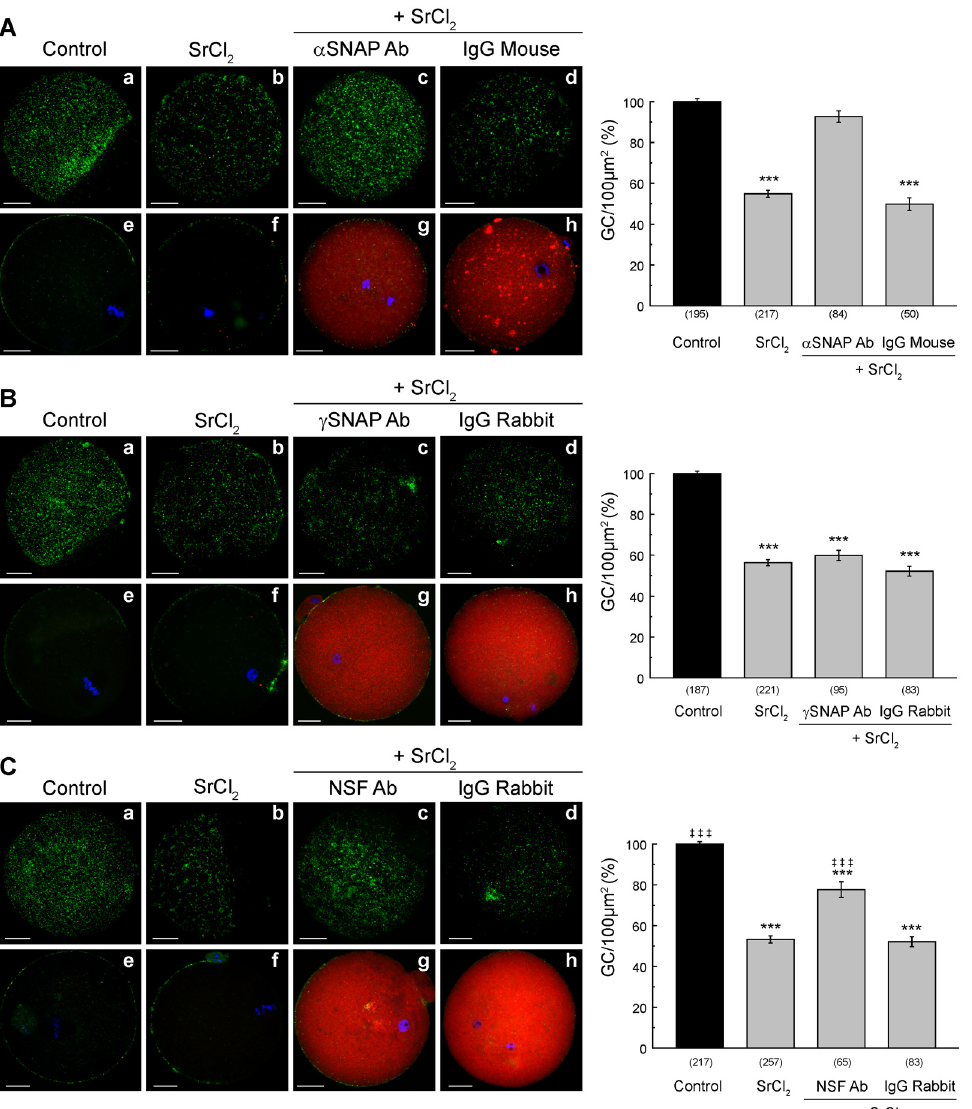
Fig 6. Effect of microinjection of α -SNAP, γ -SNAP and NSF antibodies on CGE. MII oocytes were microinjected with α -SNAP ( A ), γ -SNAP ( B ), and NSF ( C ) antibody and CGE was triggered with 30mM strontium chloride (SrCl 2 ). Mouse and rabbit IgGs were microinjected as isotype controls at the same concentrations. Left : a - d , representative images of cells stained with FITC-LCA to label CG. e - h , representative images of oocytes subjected to inmunofluorescence protocol, were primary antibody was omitted, and secondary antibodies: Cy3 donkey anti-mouse in A , and Cy3 donkey anti-rabbit in B and C , were used to confirm proper microinjection of antibody or control isotype (red). Right ,Histogram showing % CG density/100 μ m 2 relative to untreated group (Control) set as 100%. Data are shown as mean ± SEM from at least 4 independent experiments; numbers in parentheses below bars represent total number of oocytes. *** , values compared to control, p (cid:1) 0.001; ‡ ‡ ‡ , values compared to SrCl 2 , p (cid:1) 0.001. Scale bar: 20 μ